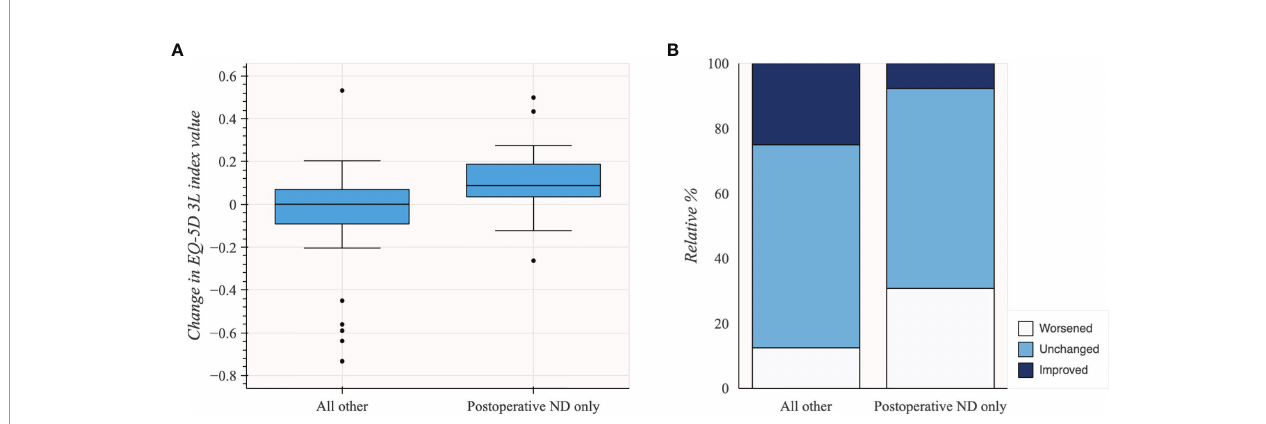
FIGURE 6 | Change in the EQ-5D 3L index value in patients grouped by change in neurological de fi cit (ND) from admission to follow-up ( N = 45). (A) Box plot illustrating distribution of change in EQ-5D 3L index values. (B) Stacked bar plot illustrating change using MCID